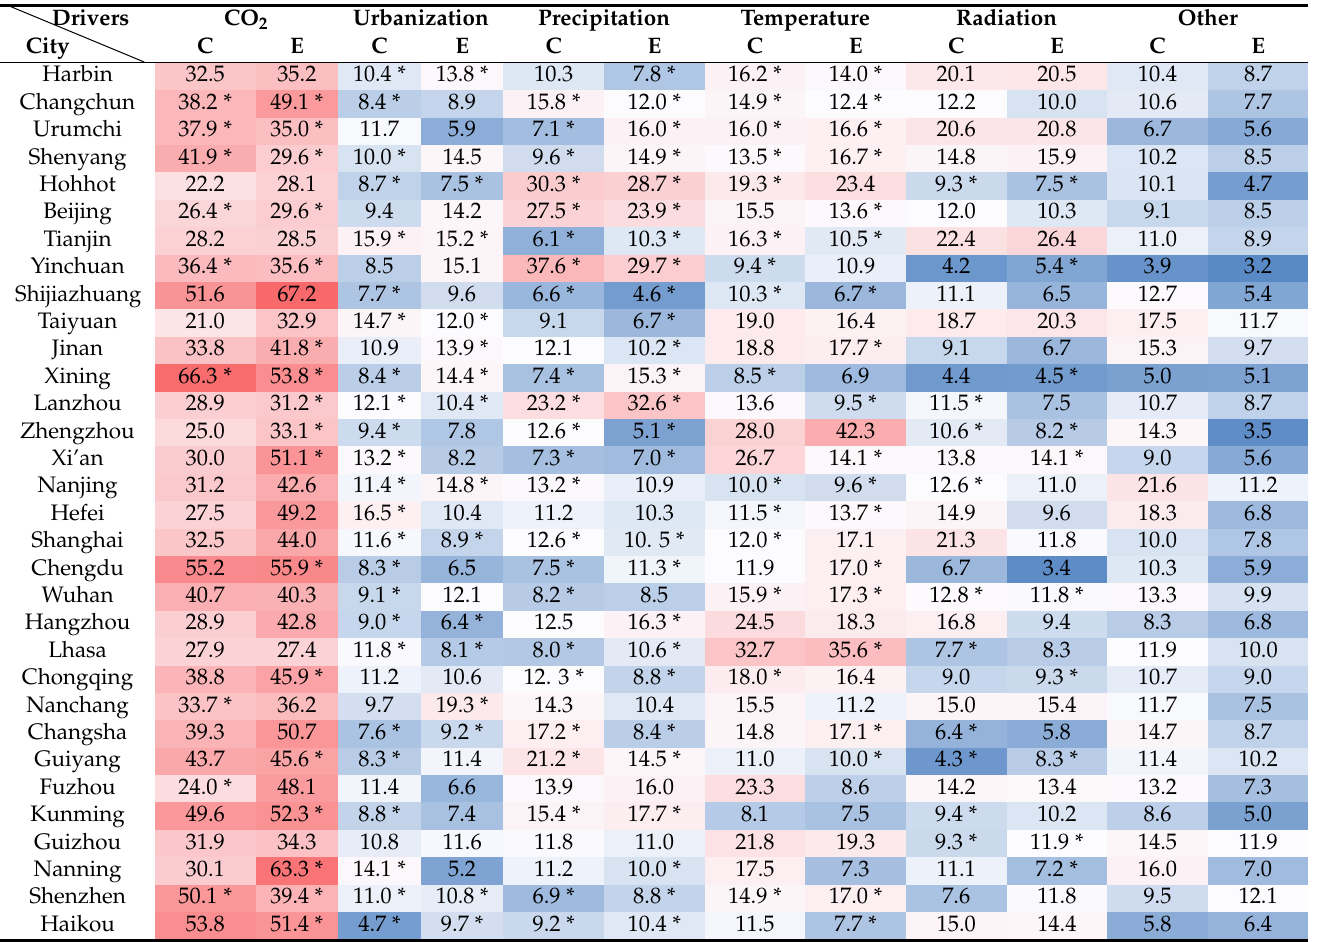
Table 3. Importance of driving factors to FVC changes in 32 cities. Red shading denotes greater importance, and blue shading represents lower importance (Unit: %). An asterisk indicates that the GLM regression coefficient is greater than